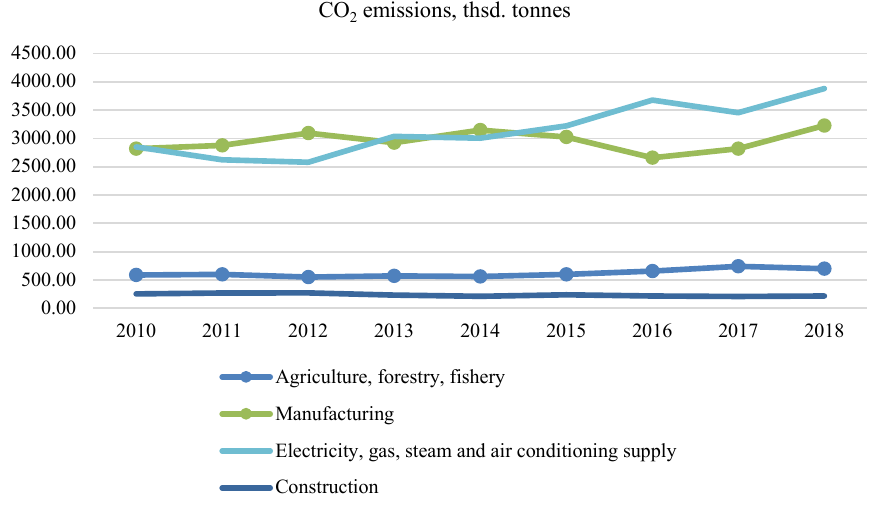
Fig. 2 . СО 2 emissions in Latvia sectors in 2010–2018